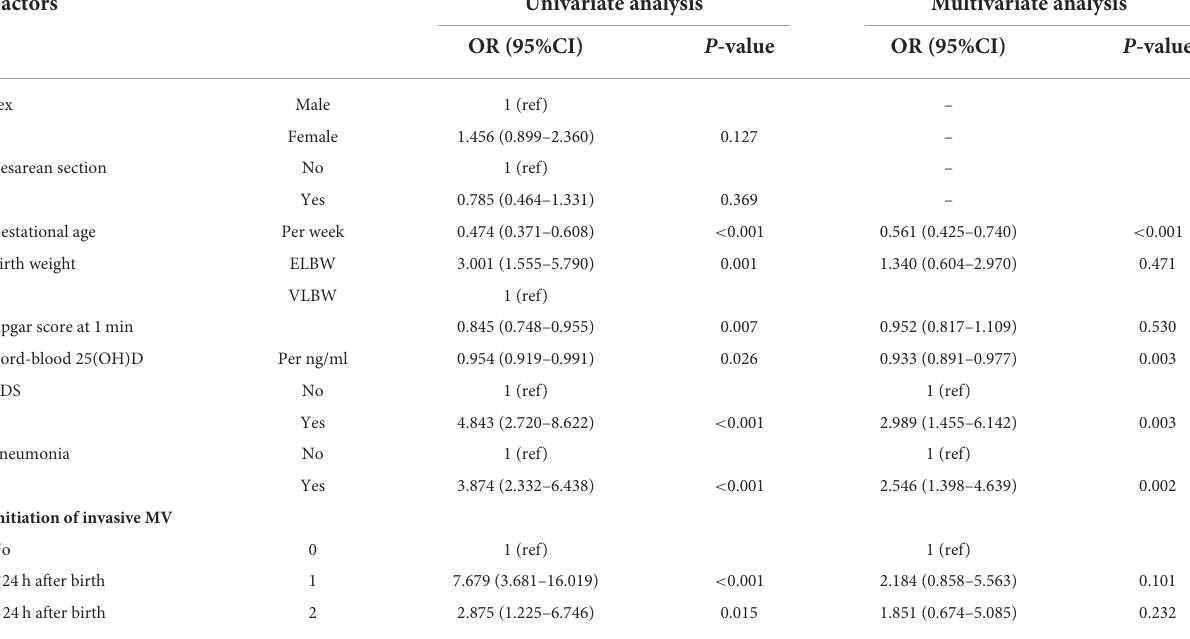
TABLE 3 Factors associated with bronchopulmonary dysplasia (BPD) in very low birth weight (VLBW) and extremely low birth weight (ELBW) preterm